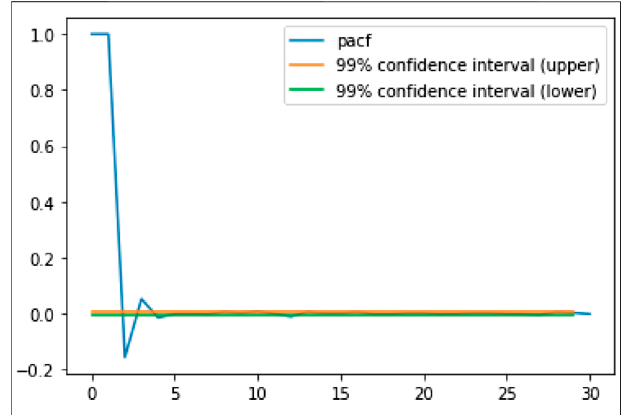
FIGURE 2 | The partial autocorrelogram (PACF) for 1 min snapshots of Bitcoin mid-prices (USD) over the period January 1, 2018 to November 10,